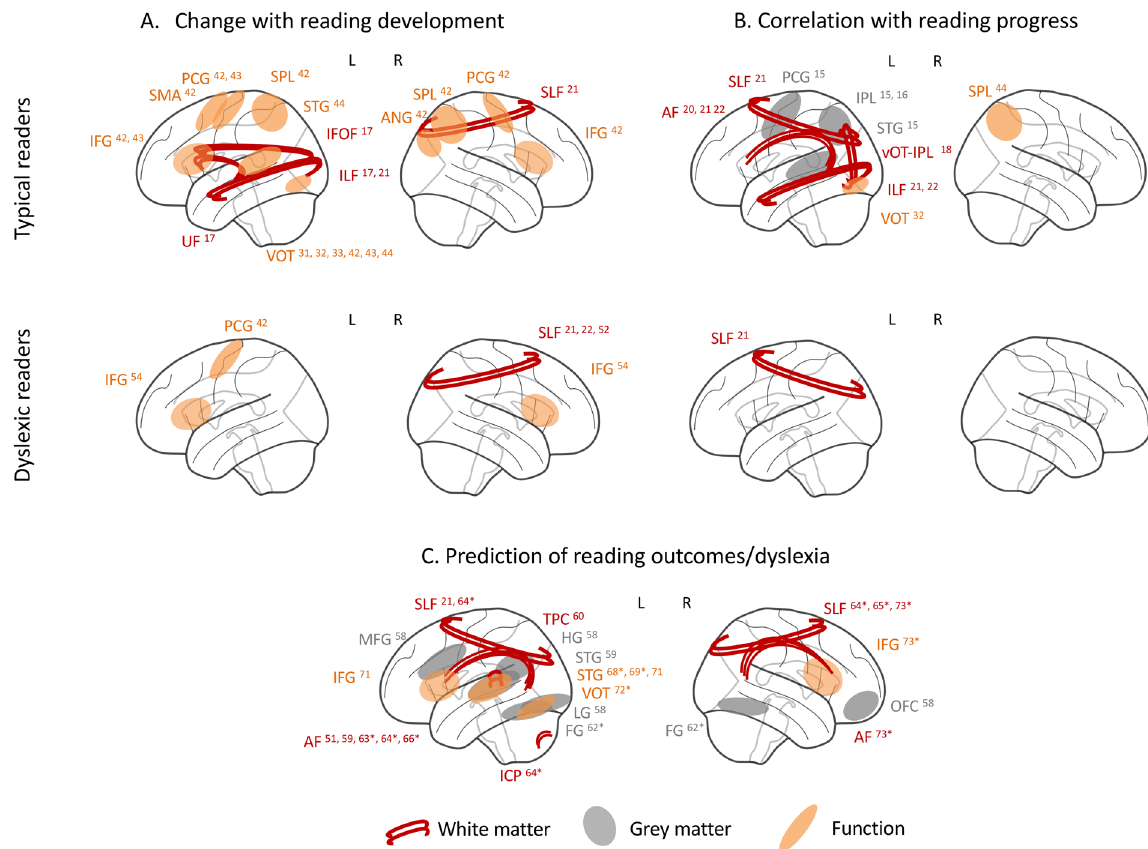
Fig. 1 Schematic of key structures reported in longitudinal studies of reading and dyslexia. a Brain regions showing changes in longitudinal comparisons. b Longitudinal changes that were correlated with reading development. c Regions that predict future reading skills. Numbers indicate references summarized in Supplementary Data and asterisk indicates prediction studies with only one neuroimaging time point. NOTE: Numbers correspond to references and summaries included in Supplementary Data. Asterisks (*) mark the studies with one neuroimaging time point predicting reading development.White matter: AF Arcuate Fasciculus, IFOF Inferior Fronto-Occipital Fasciculus, ICP Inferior Cerebellar Peduncle, ILF Inferior Longitudinal Fasciculus, SLF Superior Longitudinal Fasciculus, TPC Temporo-Parietal Cortex, UF Uncinate Fasciculus. Grey matter/function: ANG Angular, FG Fusiform Gyrus, HG Heschl Gyrus, IFG Inferior Frontal Gyrus, IPL Inferior Parietal Lobule, L Lingual Gyrus, OFC Orbito-Frontal Cortex, PCG Precentral and Postcentral Gyri, STG Superior Temporal Gyrus, SPL Superior Parietal Lobule, vOT ventral Occipito-temporal